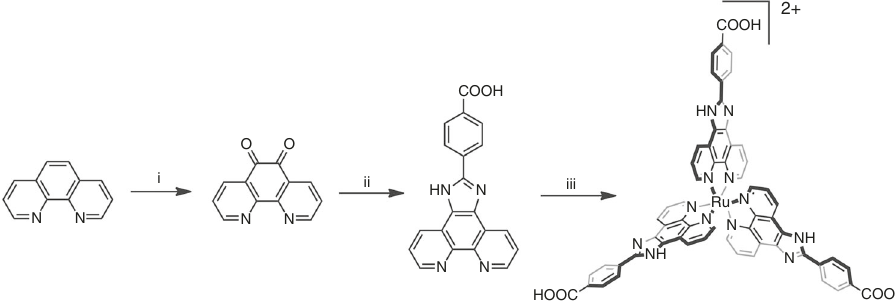
Fig. 1 Synthesis of H 3 L . Chemical structure of the tricarboxylate metalloligand used in the synthesis of Eu-Ru(phen) 3 -MOF. (i) HNO 3 , H 2 SO 4 , KBr, NaOH, 90 °C, 96% yield; (ii) 4-carboxybenzaldehyde, HAc, 100 °C, NH 4 Ac, 120 °C, 88% yield; (iii) RuCl 3 ·3H 2 O, EG, 180 °C, KFP 6 (aq), NaOH(aq), THF,